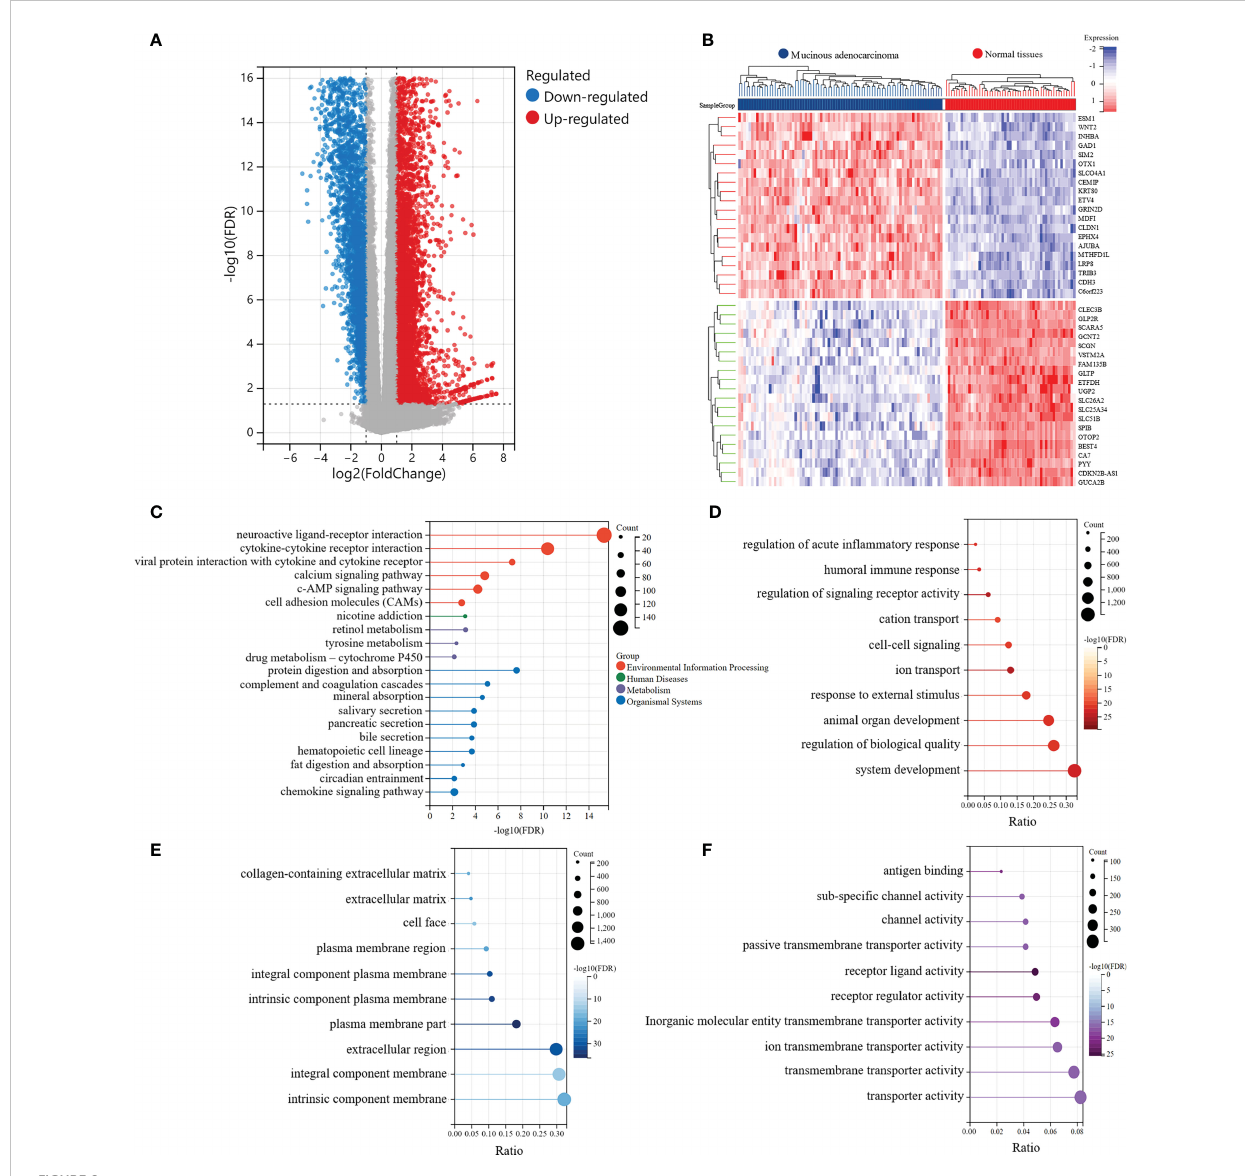
FIGURE 2 Identi fi cation of the signi fi cantly differentially expressed genes (DEGs) between MAC and normal tissues of TCGA data. (A) Volcano plot of the differential expression and distribution of the TCGA RNA sequencing data between mucinous adenocarcinoma (MAC) and normal tissues. (B) Heatmap of the top 20 up-regulated and down-regulated genes in MAC, compared with normal tissues. (C-F) Kyoto Encyclopedia of Genes and Genomes (KEGG) and Gene Ontology (GO) functional enrichment analysis of the DEGs (FDR < 0.01). (C) The functions of the DEGs in KEGG pathways. (D) Top 10 pathways of the DEGs involved in GO biological process (BP) terms. (E) Top 10 pathways of the DEGs involved in GO cellular component (CC) terms. (F) Top 10 pathways of the DEGs involved in GO molecular function (MF)